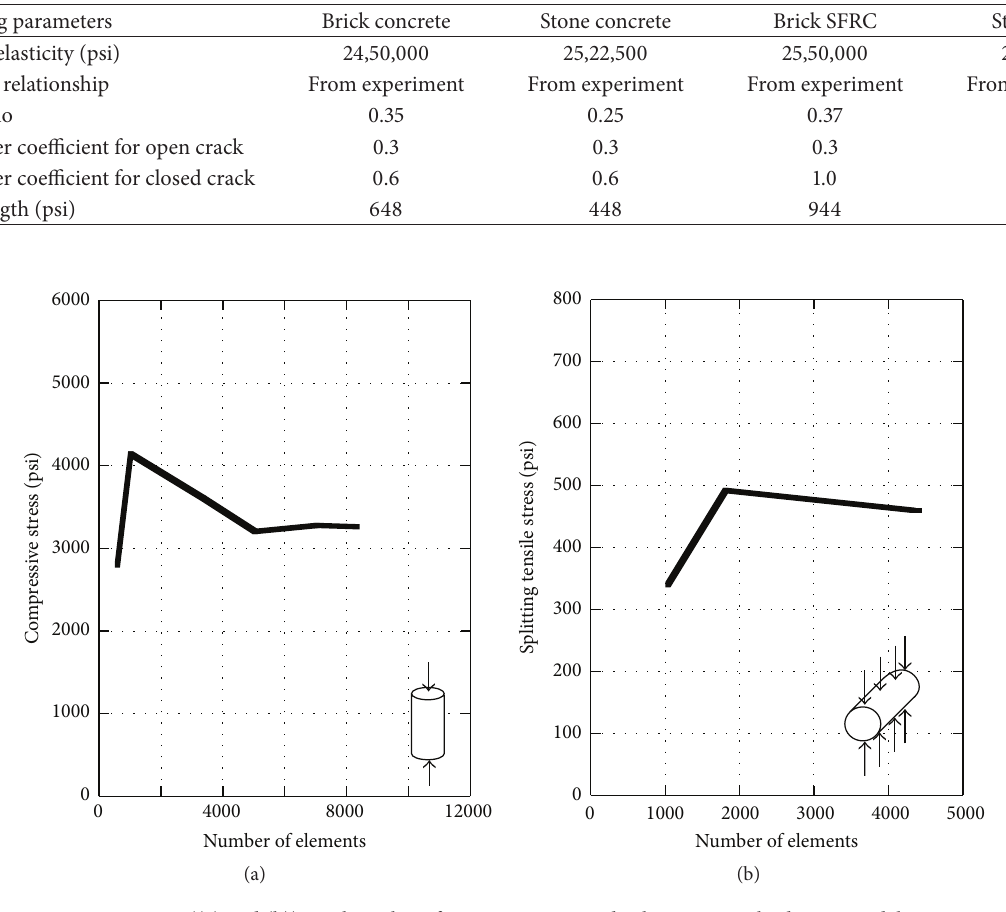
Figure 6: ((a) and (b)) Mesh analysis for compression and split tension cylinder FE